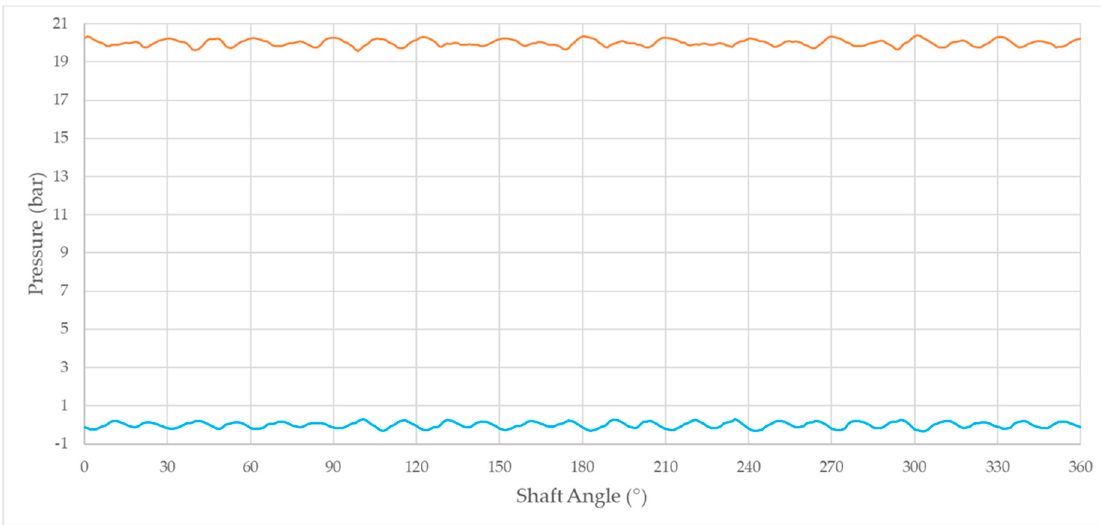
Figure 12. Pressure ripple at suction (blue) and delivery (orange) ports.